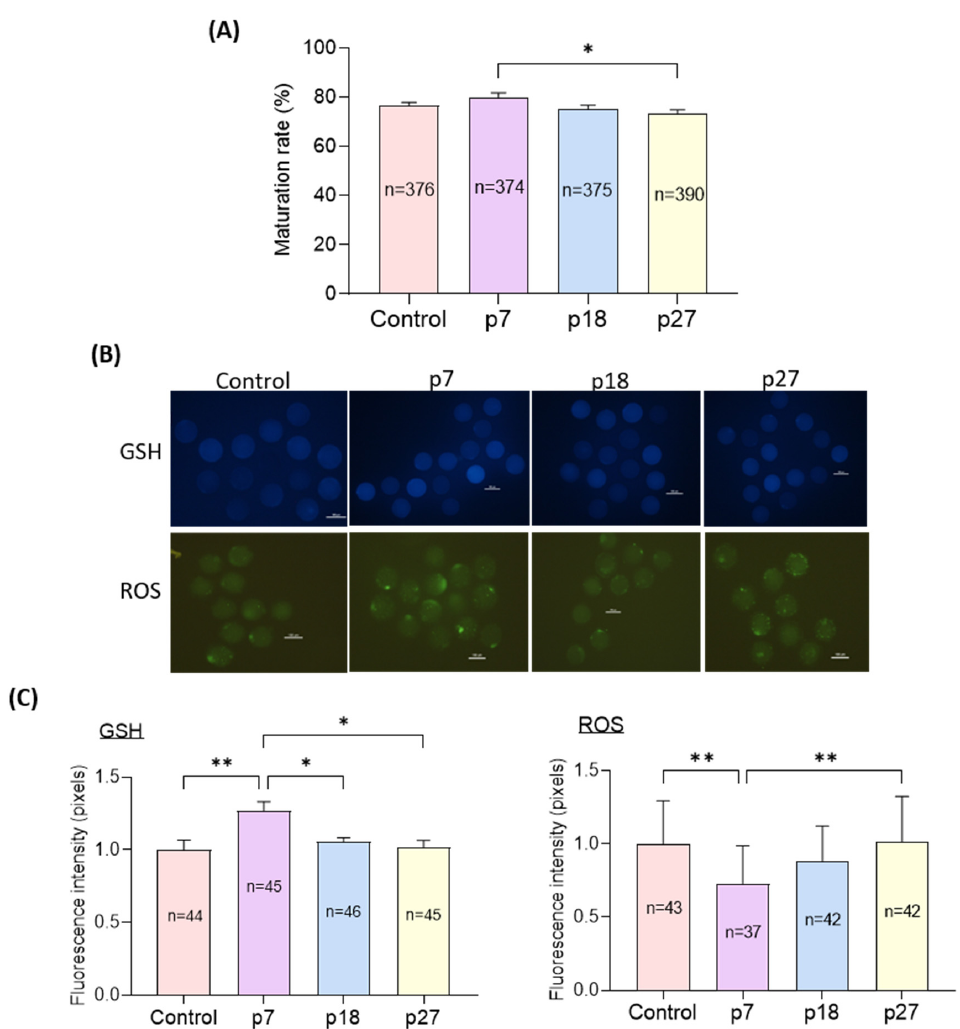
Figure 3. Effects of different passages of eAFMSC-CM on oocyte cytoplasmic maturation. ( A ) Rates of matured oocytes. ( B ) Images of oocytes stained with CMF2HC and DCFHDA. ( C ) Quantification of the intracellular GSH and ROS levels in MII oocytes. The asterisks represent significantly different when compared to the control (*: p < 0.05, **: p < 0.01). Scale bar = 100 μ m.